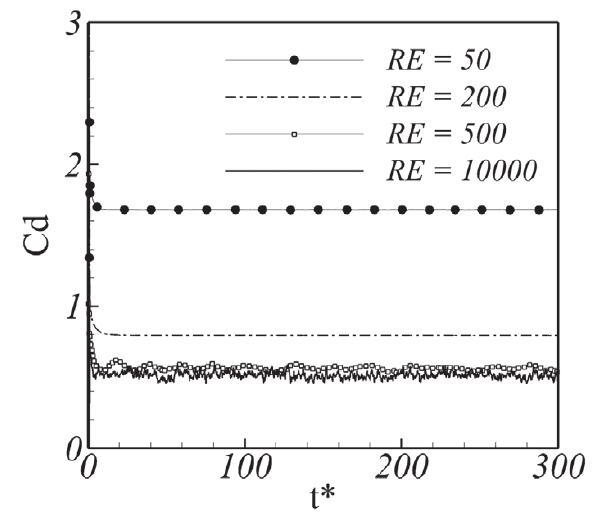
Figure 18 - Time distribution of the drag coefficient for four values of the Reynolds number.